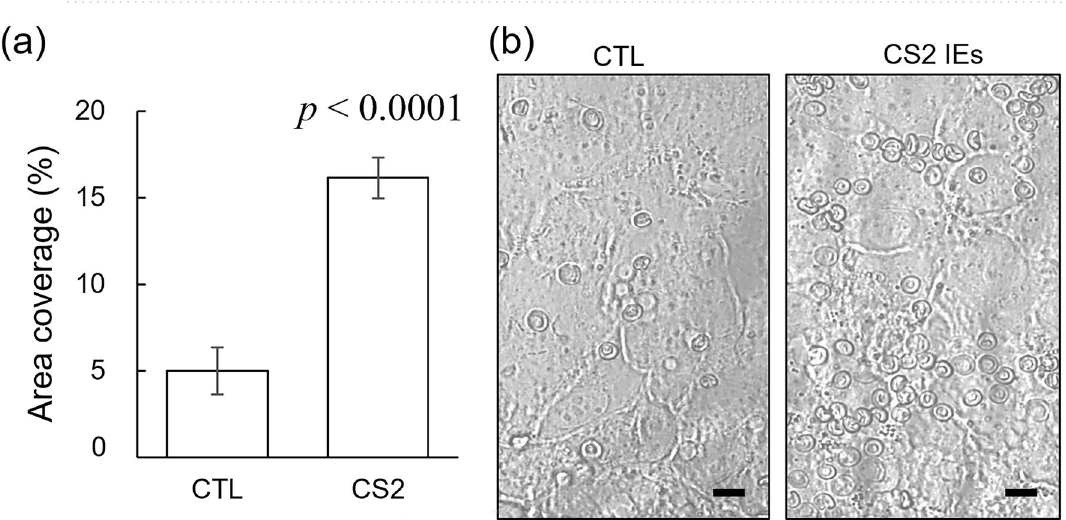
Figure 3. IE sequestration in placental barrier. ( a ) Adhesion of IEs and uninfected erythrocytes (CTL) to the placental barrier, as quantified by the percent of area coverage by erythrocytes. Errors bars show 1 SD. Data represent measurements made in 3 independent experiments. ( b ) Representative images of erythrocyte adhesion under CTL and CS2 conditions (at a parasitemia value of 50%). Scale bar: 10